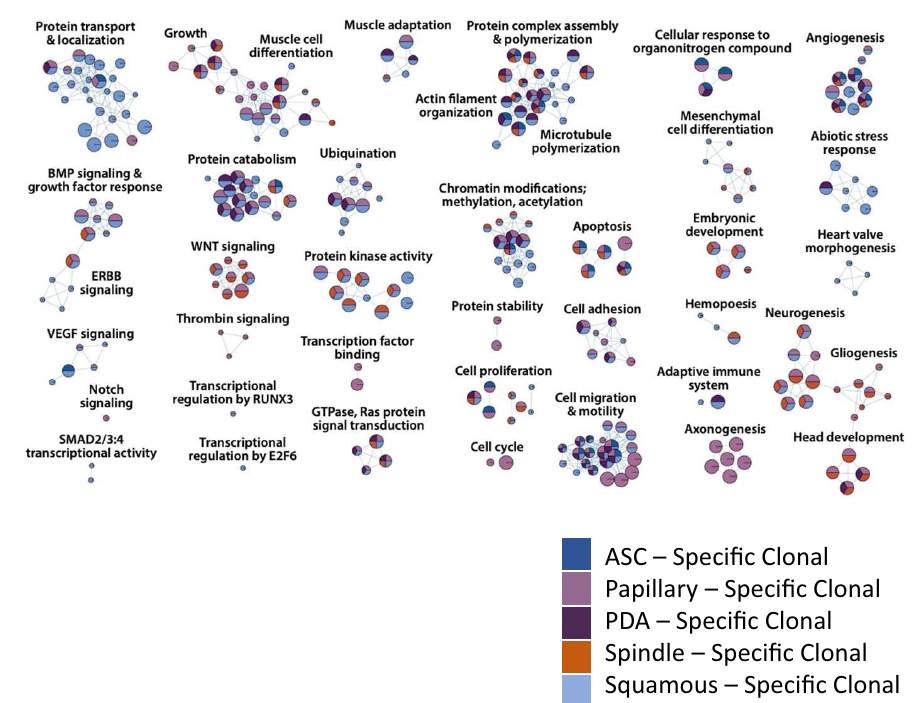
Fig. 5 Pathway analysis identi fi es histology-speci fi c pathways and processes in transformation of mammary epithelium. Pathways altered by SB mutagenesis in histology-speci fi c subscreens (FDR corrected P -value < 0.05). Enrichment map shows enriched pathways and processes as nodes, while pathways with many shared genes are connected and cluster into subnetworks. Node colors indicate cohorts where gCIS events were enriched in the corresponding pathways. One-sided ranked hypergeometric tests were used and signi fi cant pathways visualized. p -value information for nodes are found in Supplementary Data